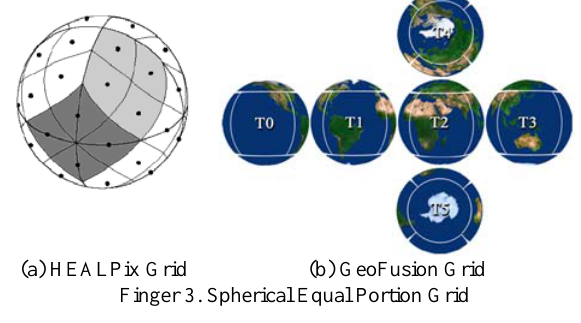
Finger 3. Spherical Equal Portion